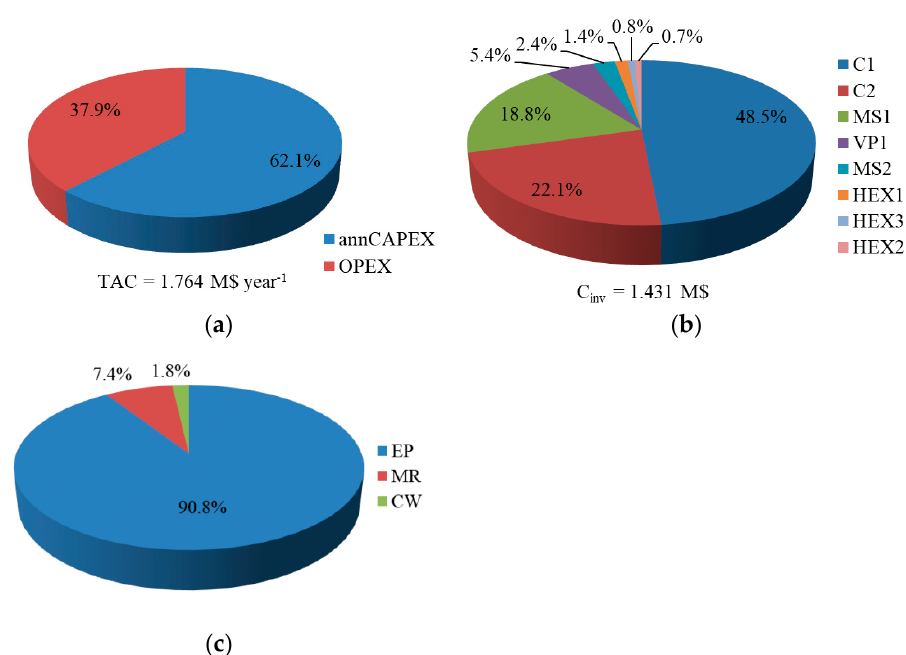
Figure 4. Optimal cost distributions: ( a ) contributions of the total annualized capital expenditures (annCAPEX) and total operating expenditures (OPEX) to the total annual cost (TAC); ( b ) Equipment investment (C INV ); ( c ) contributions of the electric power (EP) cost, membrane replacement (MR) cost, and cooling water (CW) cost to the total utility cost (C RM ).